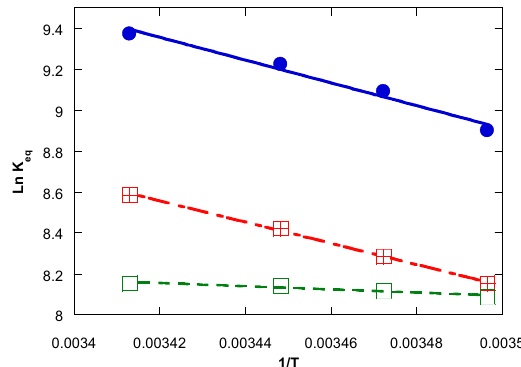
Figure 5. The plot of LnK